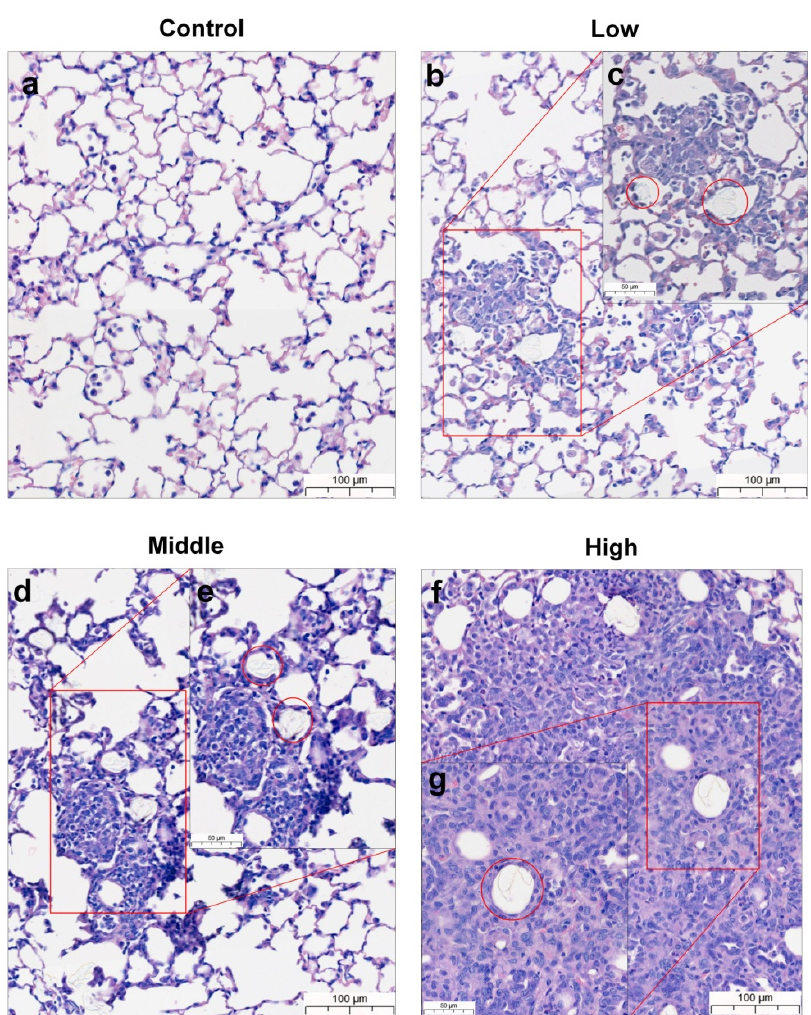
Figure 4. Lung histopathological evaluation of mice from 28-day repeated oral dose toxicity study. Lungs of male mice from ( a ) control group, ( b , c ) low-dose group, ( d , e ) mid-dose group, and ( f , g ) high-dose groups. Left picture represents low magnification, and right is magnified area of red box. Foreign bodies presumed to be polyethylene microplastics in alveolar space of lung (red circle). Scale bar = 100 μ m, 50 μ m.